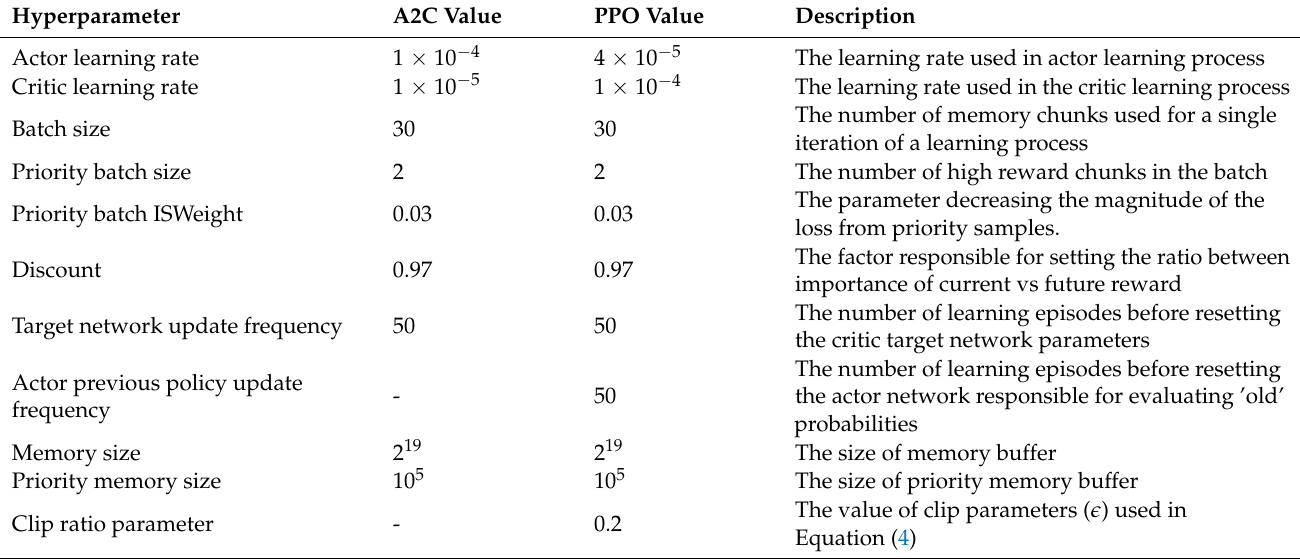
Table 2. Hyperparameters used during the